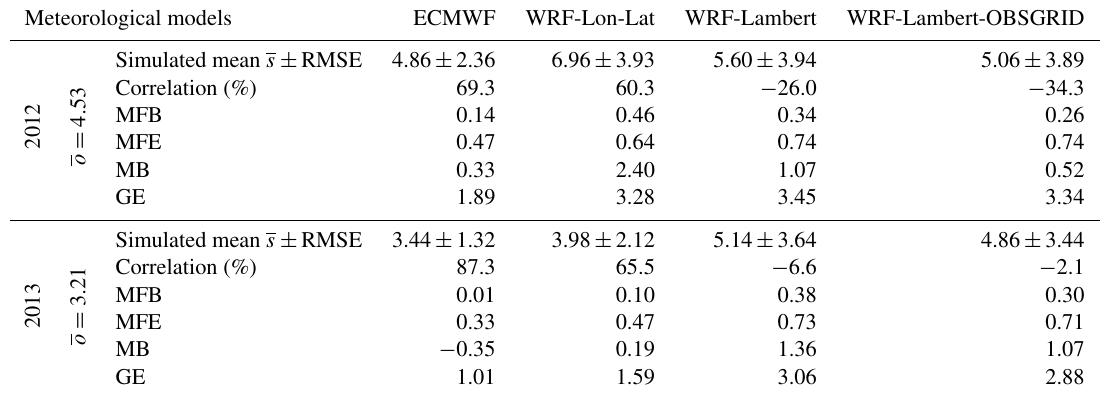
Table 4. Wind speed statistics for the four meteorological models at Ersa during the 2012 and 2013 summer campaigns. The wind speed means and the RMSEs are in ms − 1 . o refers to the measured